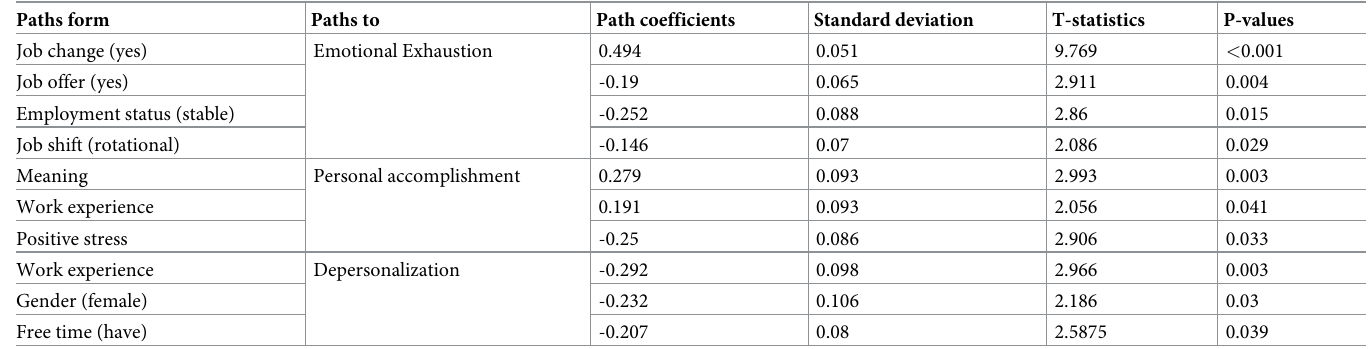
Table 4. PLS path modeling results for significant paths.